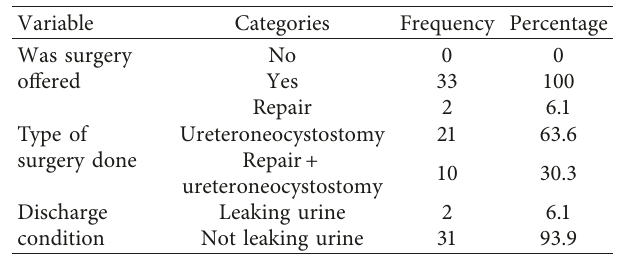
Table 4: Renal function at admission.